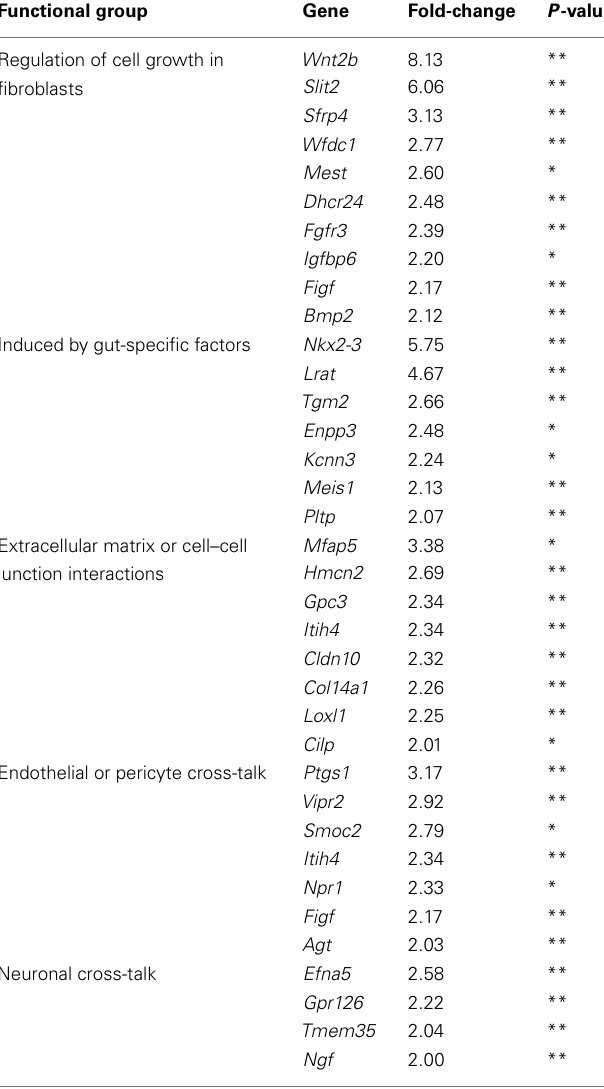
Table 3 | Genes upregulated in FRCs from mesenteric lymph nodes compared to FRCs from skin-draining lymph nodes, grouped by functional